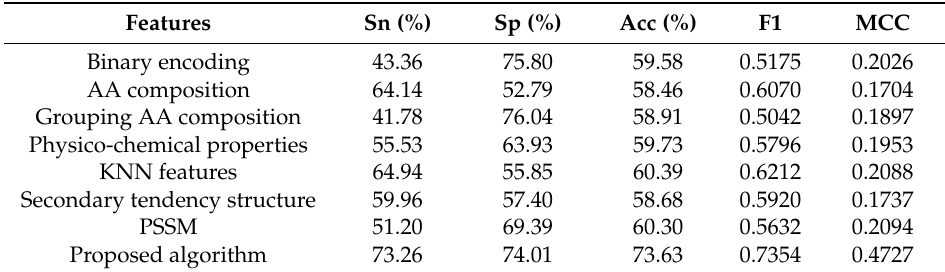
Table 1. Performances of different features in E. coli . Sn—sensitivity; Sp—specificity; Acc—accuracy; MCC—Matthew’s correlation coefficient.